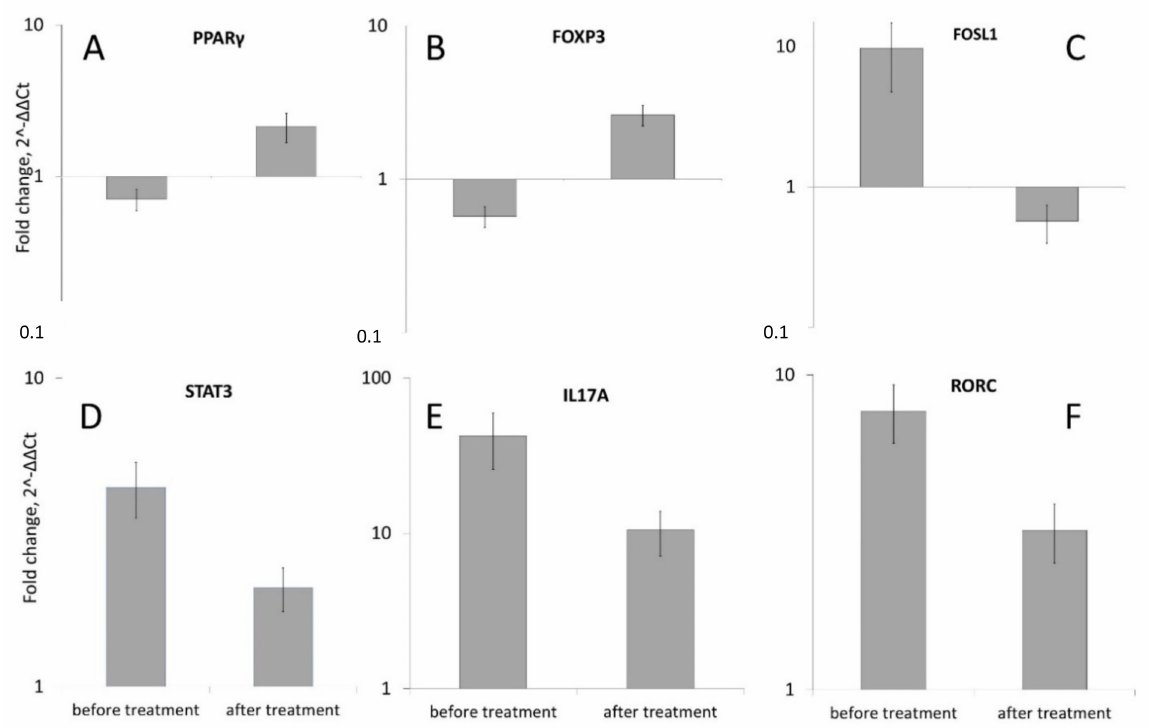
Figure 6. Comparison of PPAR γ ( A ), FOXP3 ( B ), FOSL1 ( C ), STAT3 ( D ), IL17A ( E ) and RORC ( F ) genes expression in the skin of 23 patients with psoriasis before and after low-level laser therapy. The levels of mRNA concentration for genes in psoriatic skin samples was calculated in relation to the level of the same genes in unaffected skin samples (which was taken as conditional 1, p < 0.05). See supplemental materials for detailed statistics (“PPARG expression